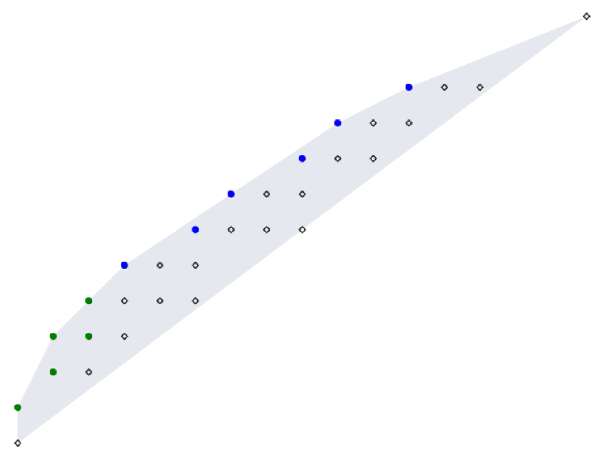
Figure 21 . Newton polygon for diag(2 ; 2 ; 3)